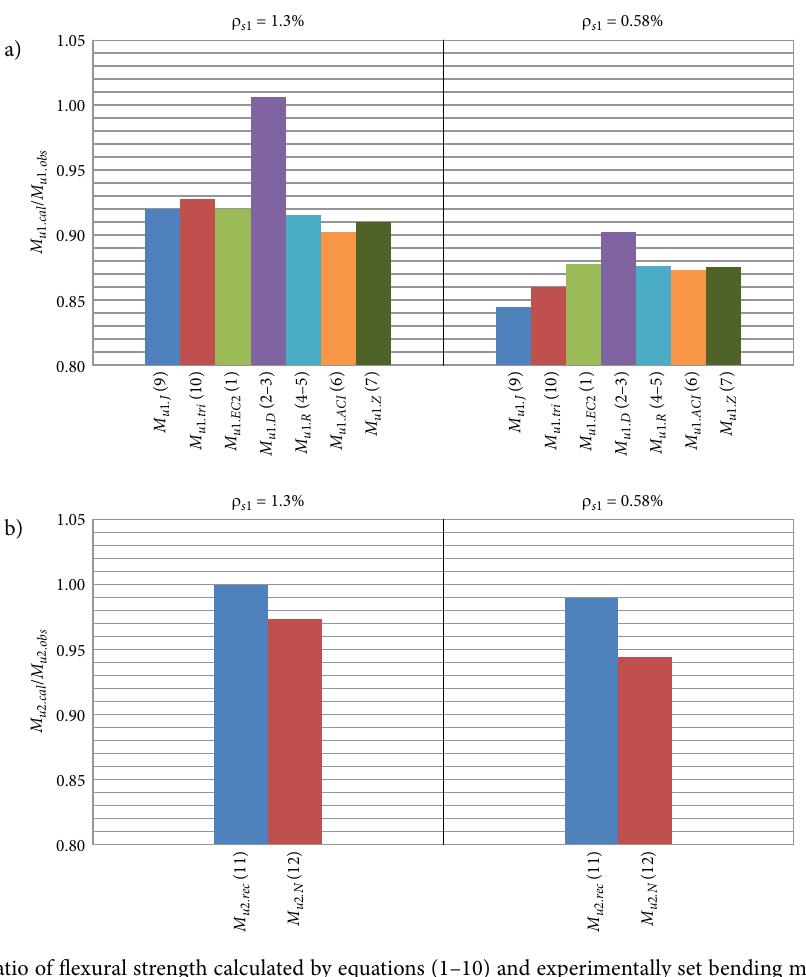
Fig. 9. a) The ratio of flexural strength calculated by equations (1–10) and experimentally set bending moment M when reinforcement stress reached yield strength; b) The ratio between moments calculated by eq. (11, 12) and experimentally set final fracture moment M